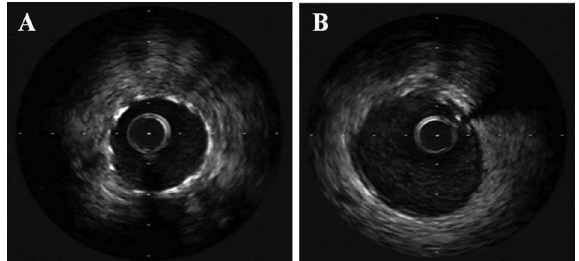
Figure 1. Intravascular ultrasound imaging of the stable (SAP) and unstable (UAP) angina pectoris groups. A , SAP group. Eccentrically-distributed fibrous plaques appeared with enhanced echo. B , UAP group. Eccentrically-distributed lipid plaques ap- peared with low echo.